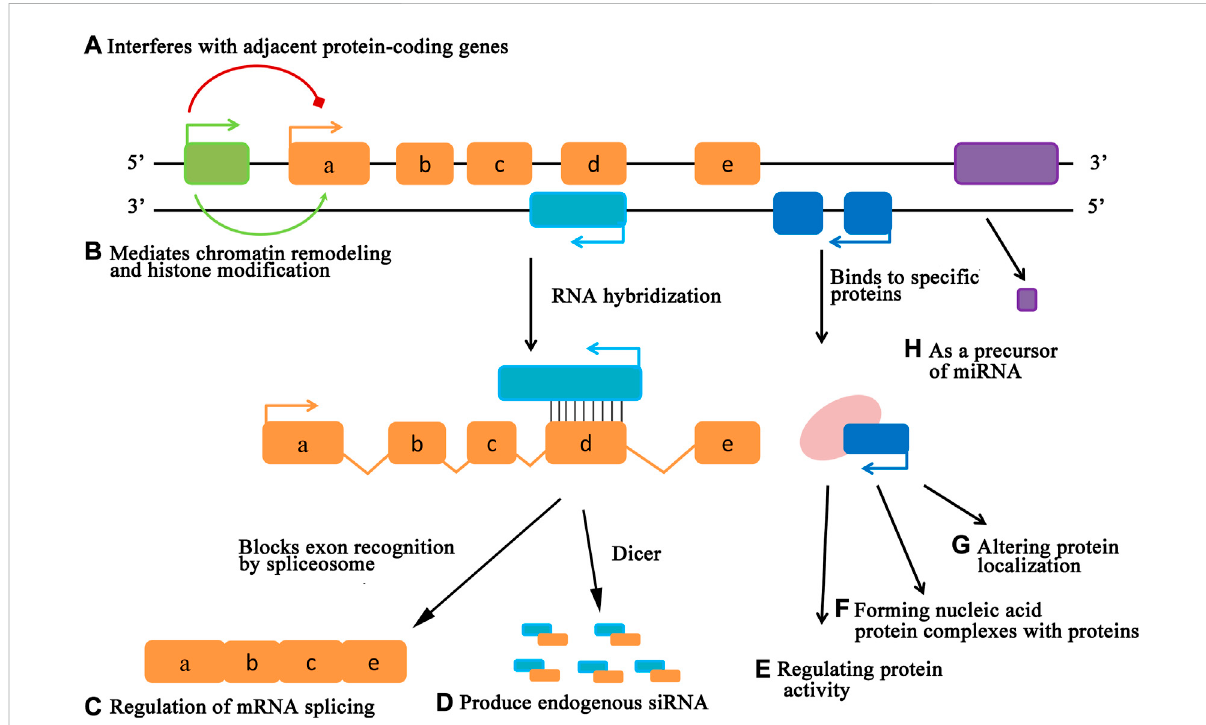
FIGURE 2 The mode of action of lncRNAs. LncRNAs can regulate gene expression levels at various levels, including epigenetic regulation, transcriptional regulation, and post-transcriptional